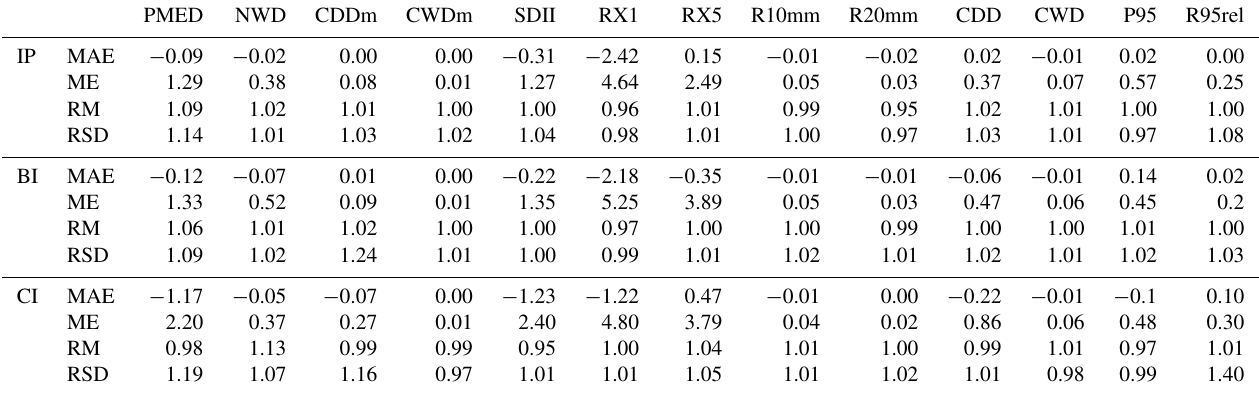
Table 6. The leave-one-out, cross-validation (LOO-CV) statistics, showing the goodness of fit between observations and estimates of daily and extreme precipitation indices. IP: Iberian Peninsula; BI: Balearic Islands; CI: Canary Islands; MAE: mean absolute error; ME: mean error; RM: ratio of means; RSD: ratio of standard deviations. Results were constrained to 2 decimal places.